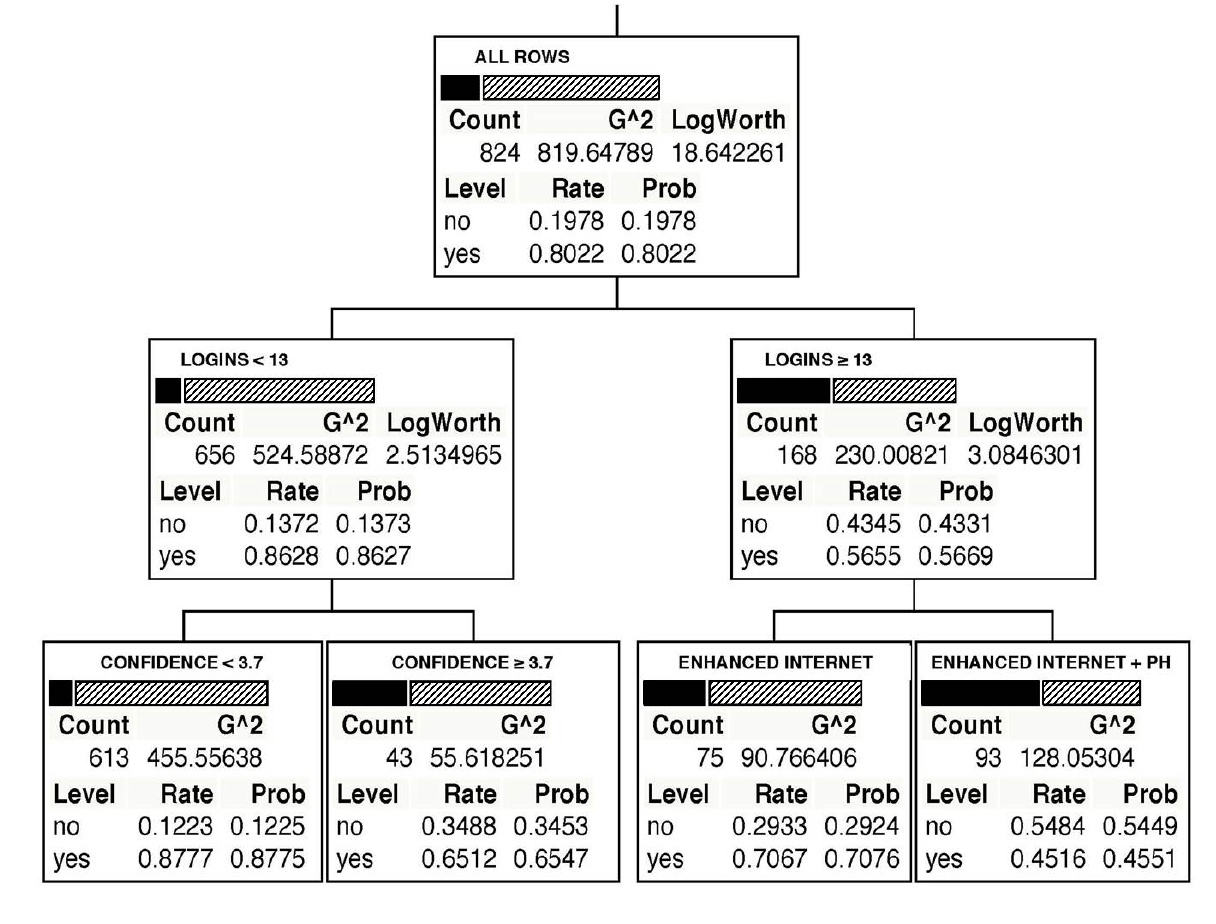
Figure 2. CART model predicting 30-day point prevalence abstinence at 3 months (n=824). Bars correspond to smoking status: solid=abstinent; diagonal lines=not abstinent. Count=total number of participants in subset; Level=smoking abstinence status (no/yes); Rate=relative proportion of the count in each abstinence status group; Logins=frequency of website logins during first 3 months of study; enhanced Internet and enhanced Internet + ph (telephone counseling)=treatment arms; Confidence=Confidence Inventory